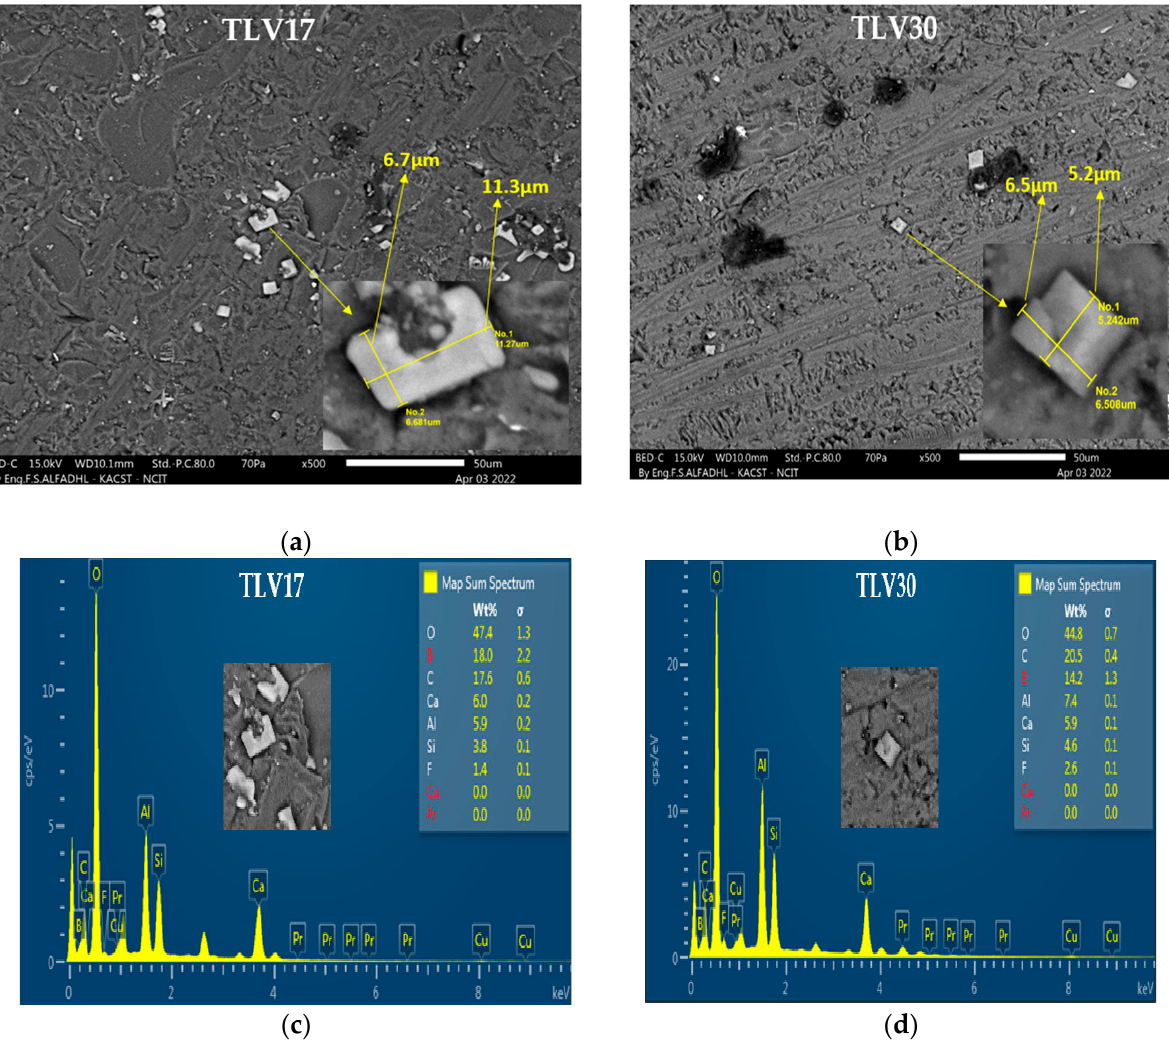
Figure 4. ( a , b ) SEM images and ( c , d ) elemental analysis EDS composition spectra for TLV17 and TLV30 samples.